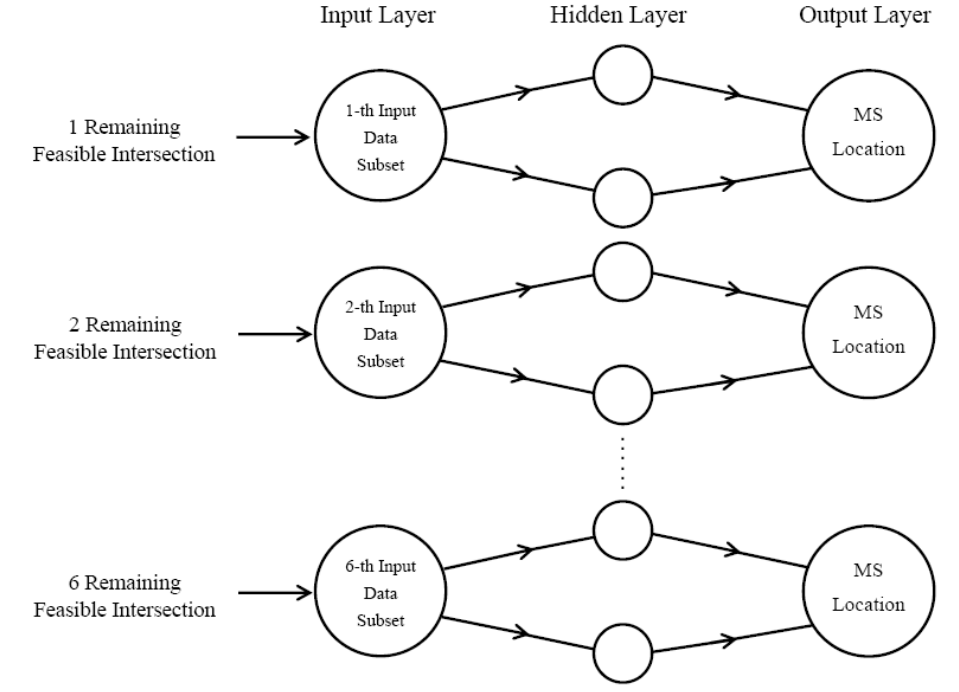
Figure 4. Structure of the prediction models for (a) Type 1 (Divided Type) and (b) Type 2 (Composite